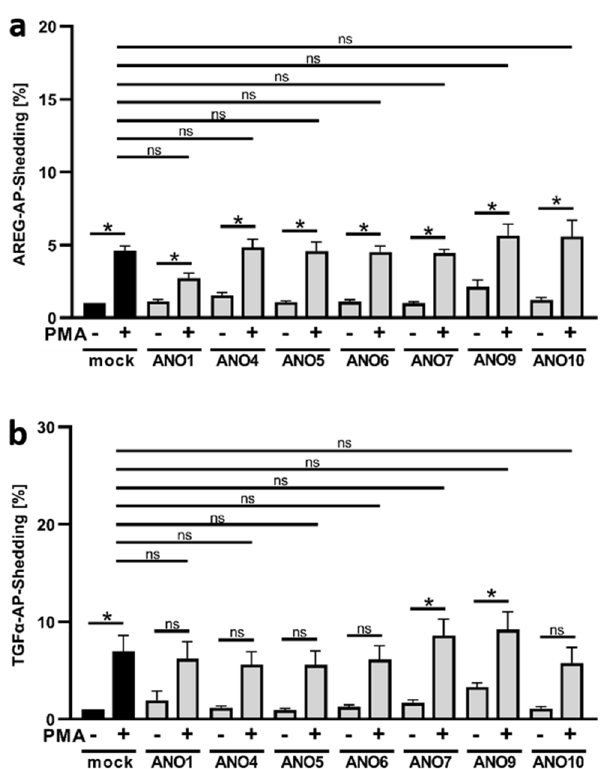
Figure 2. PMA-stimulated release of AREG and TGF α is not affected by overexpression of anoctamins. HEK293T cells were co-transfected with an ANO plasmid or mock vector (black columns) and the AP-tagged ADAM17 substrates ( a ) AREG or ( b ) TGF α . Cells were stimulated with PMA (300 ng/mL) for 30 min and analyzed for the release of soluble AREG or TGF α via AP-assay. * indicates a significant increase compared to corresponding unstimulated cells or stimulated mock control, and ns indicates no significant difference (light grey columns) (n = 3; * p < 0.05; ± SEM). Data were analyzed by one-way ANOVA and Holm–Sidak multiple comparison post hoc test.